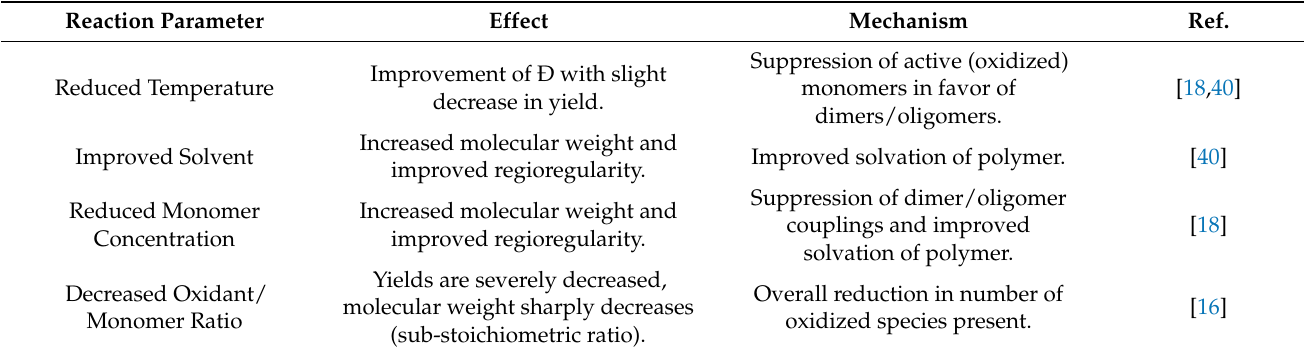
Table 2. Impact of different reaction parameters on the FeCl 3 -initiated oxidative polymerization of thiophenes.